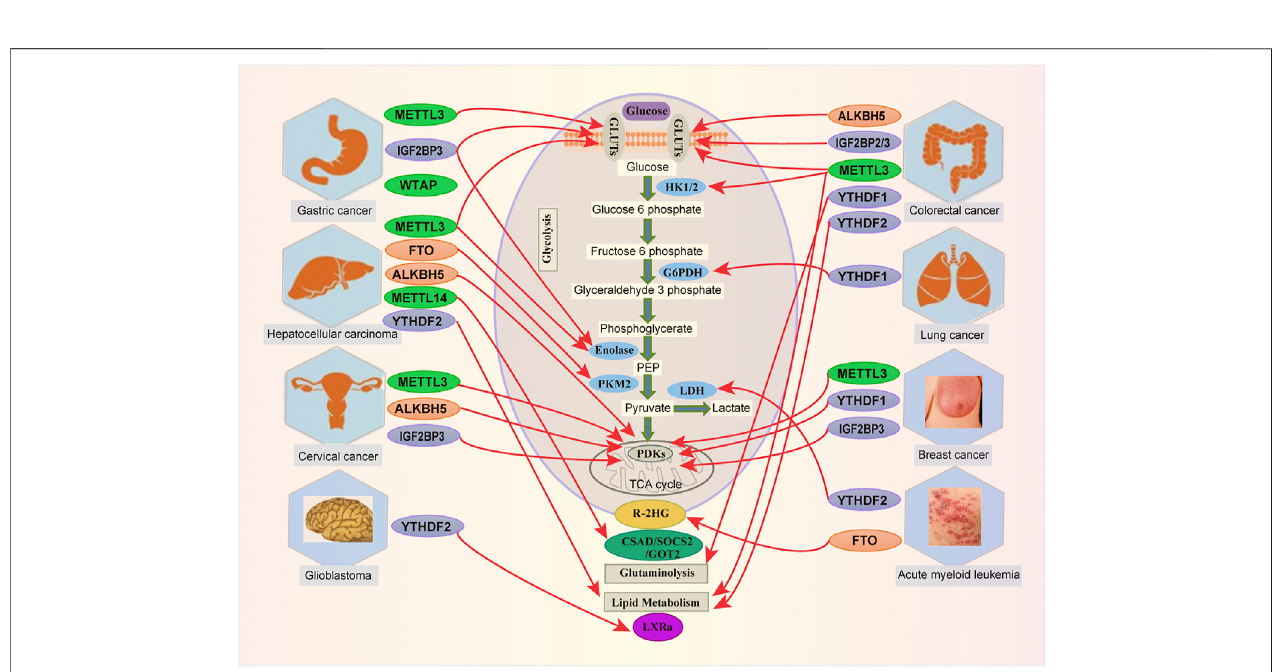
FIGURE 2 | Links between m 6 A modi fi cation and metabolites in human cancer. m 6 A RNA modi fi cation by targeting metabolic pathways is involved in various tumorigenesis, including Acute Myeloid Leukemia (AML), Breast Cancer (BC), Cervical Cancer (CC), Colorectal Cancer (CRC), Glioblastoma (GBM), Hepatocellular Carcinoma (HCC), Gastric Cancer (GC) and Lung Cancer (LC).